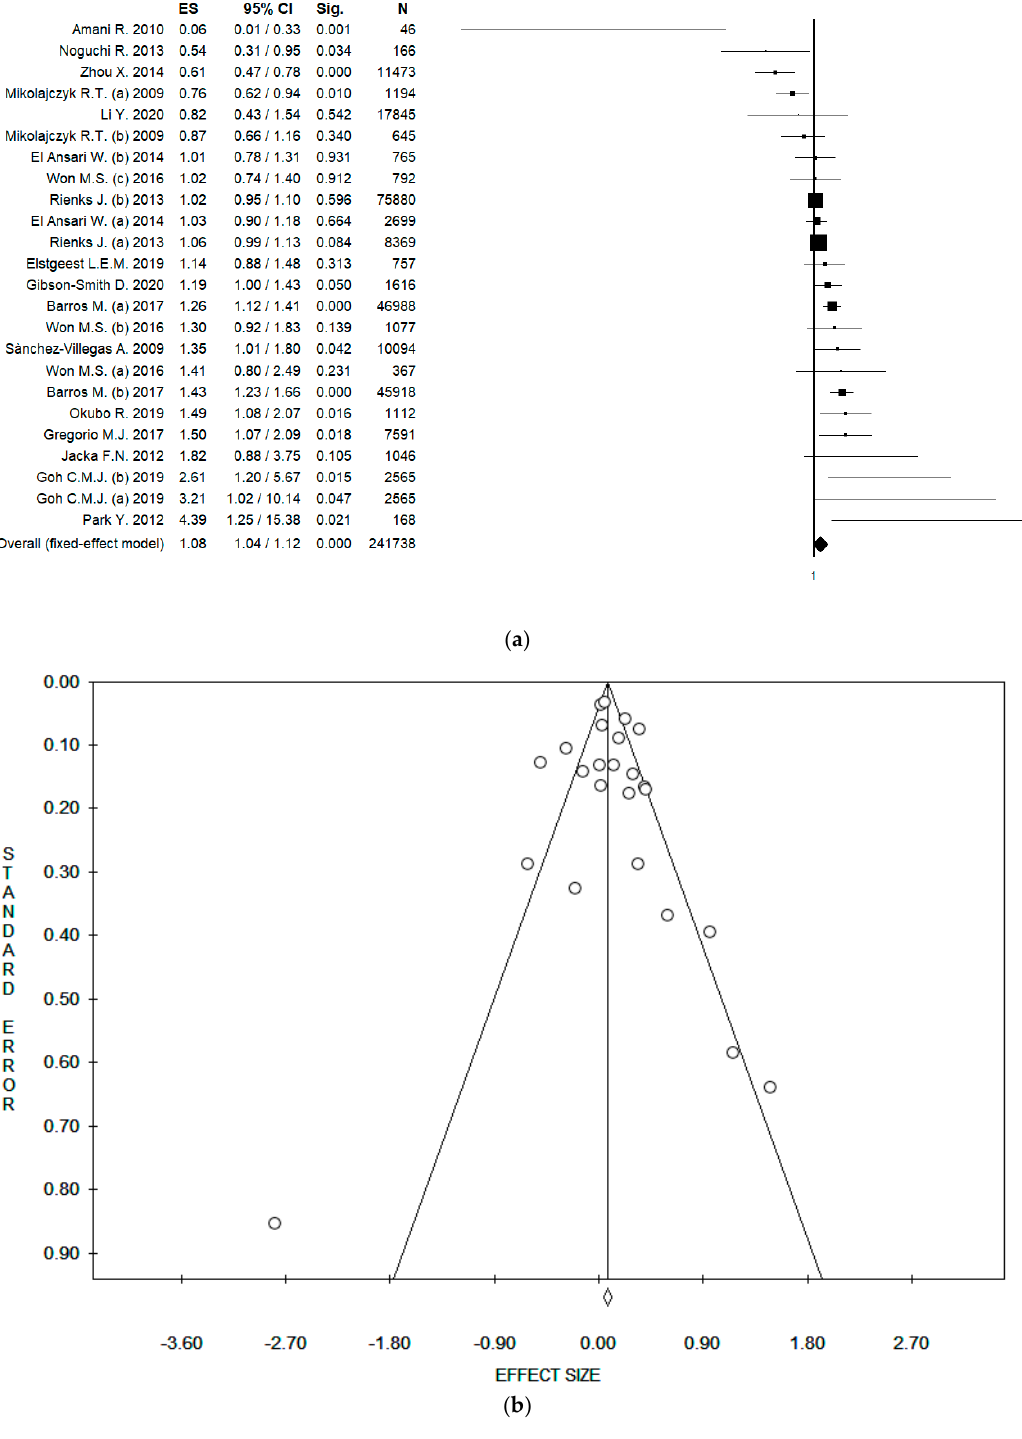
Figure 2. ( a ) Forest plot, and ( b ) funnel plot of the meta-analysis assessing the association between meat intake and depression. ES, e ff ect size; CI, confidence